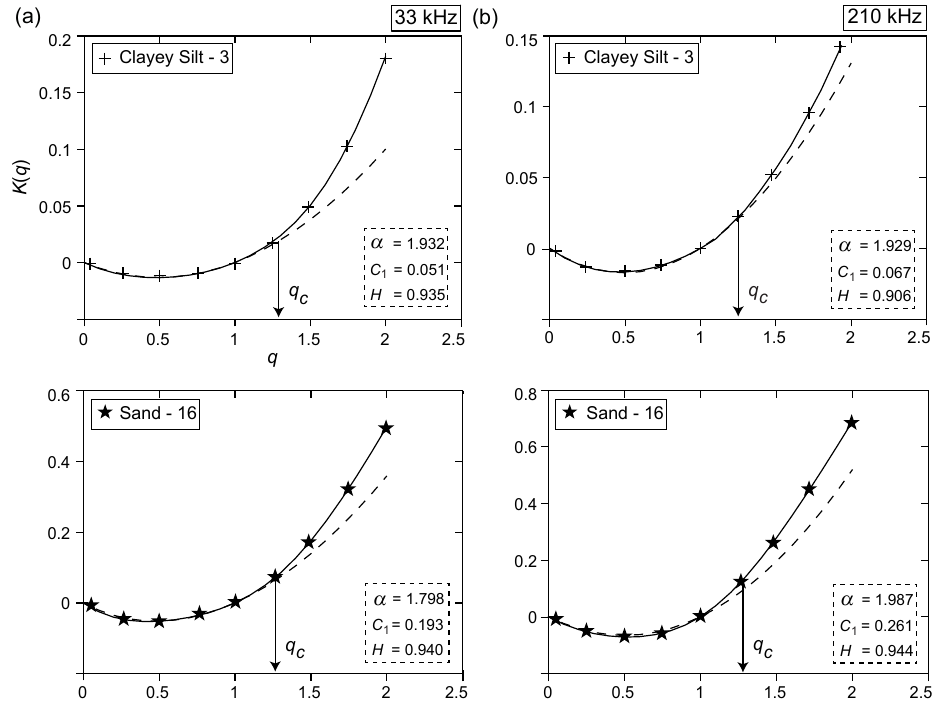
Fig. 4. Comparison between the empirical (solid curve) and theoretical (dash curve) moment scaling function K(q) as a function of q . The empirical K(q) values of the representative clayey-silt and sand substrates are determined from the logarithmic slopes of trace moments illustrated in Fig. 3. The theoretical K(q) values are calculated using Eq. (2) based on the computed α and C 1 (shown in the figure). The linear deviation of theoretical curves beyond q ≥ q c > 1.25 is indicative of a first-order multifractal phase transition, caused by the rare and violent singularities in the dual-frequency